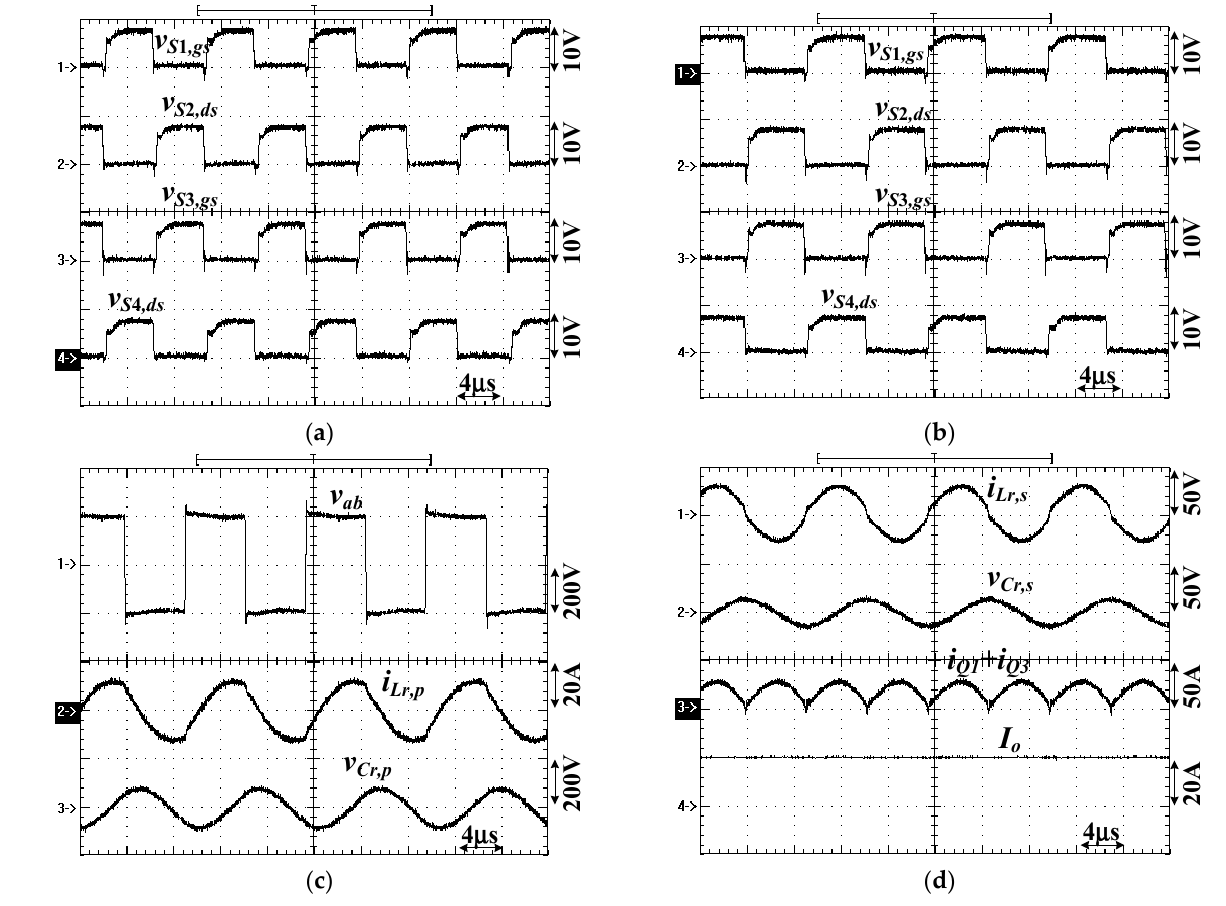
Figure 11. Measured waveforms of the proposed converter operated at forward power flow and V in = 100 V: ( a ) S 1 – S 4 signals at 20% load power, ( b ) S 1 – S 4 signals at 100% load power, ( c ) v ab , i Lr,p and v Cr,p at full rated power, ( d ) i Lr,s , v Cr,s , i Q 1 + i Q 3 and I o at full rated power.